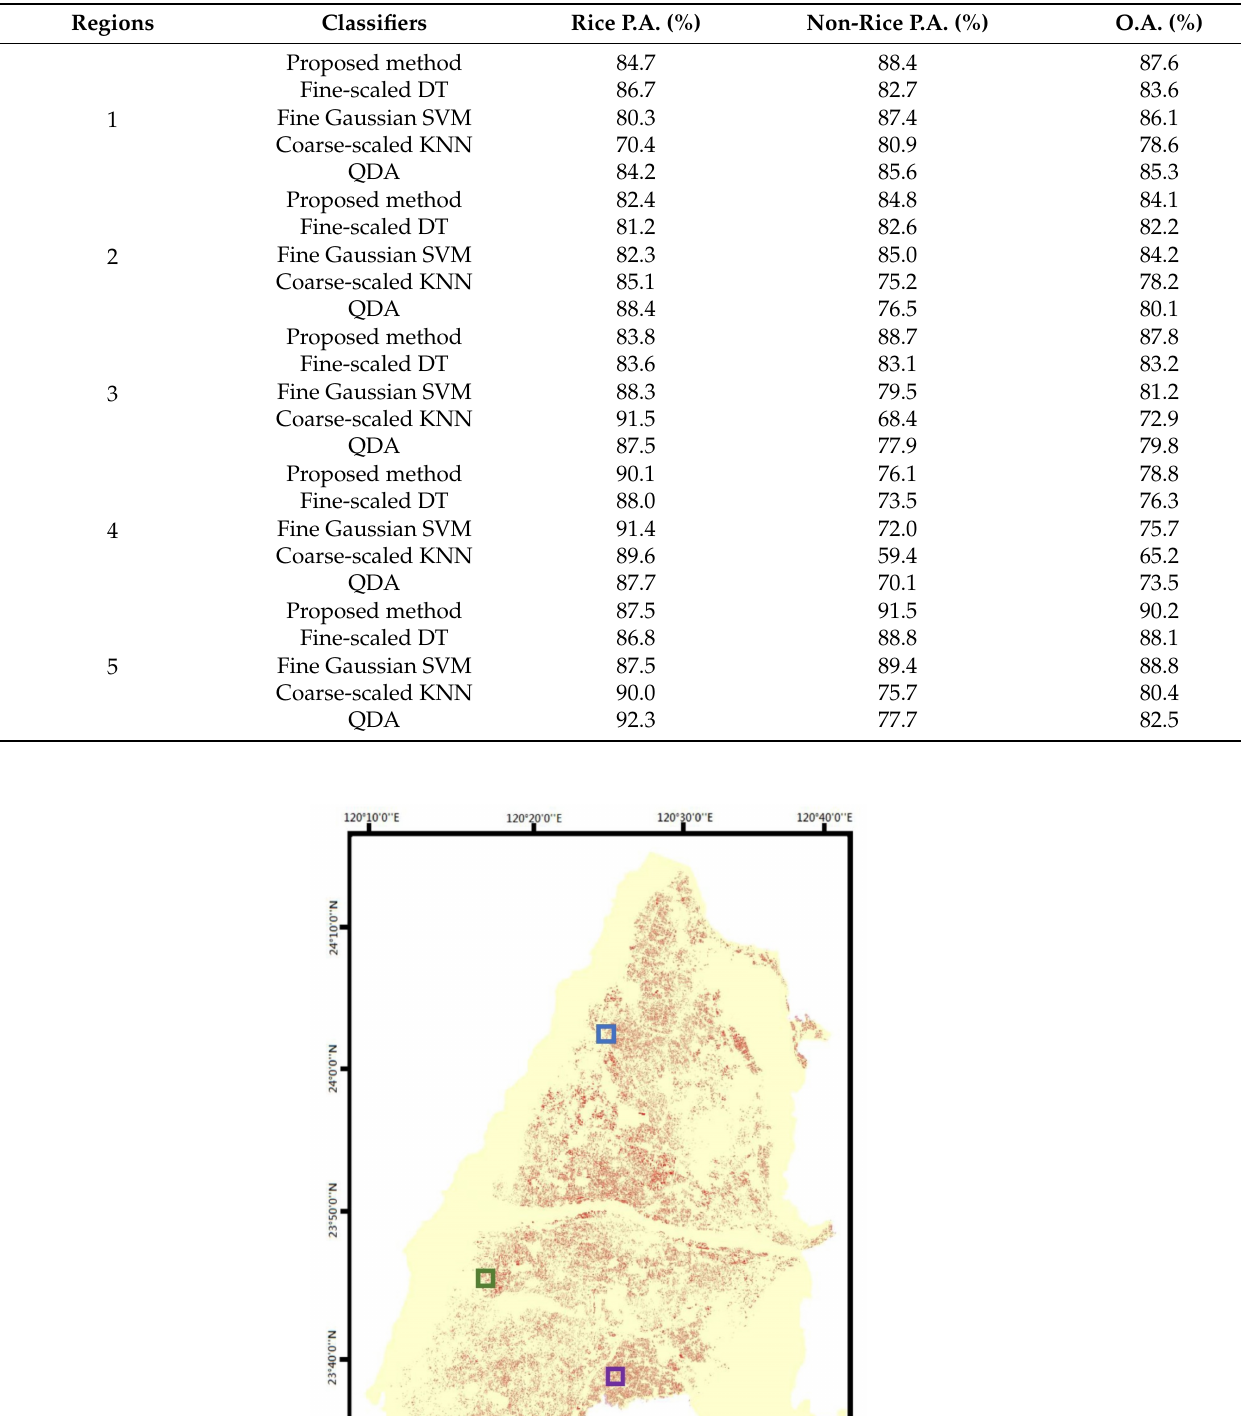
Table 7. Detection accuracy of the five regions by the proposed method and the other four classifiers for VH polarization with ascending orbit mode.